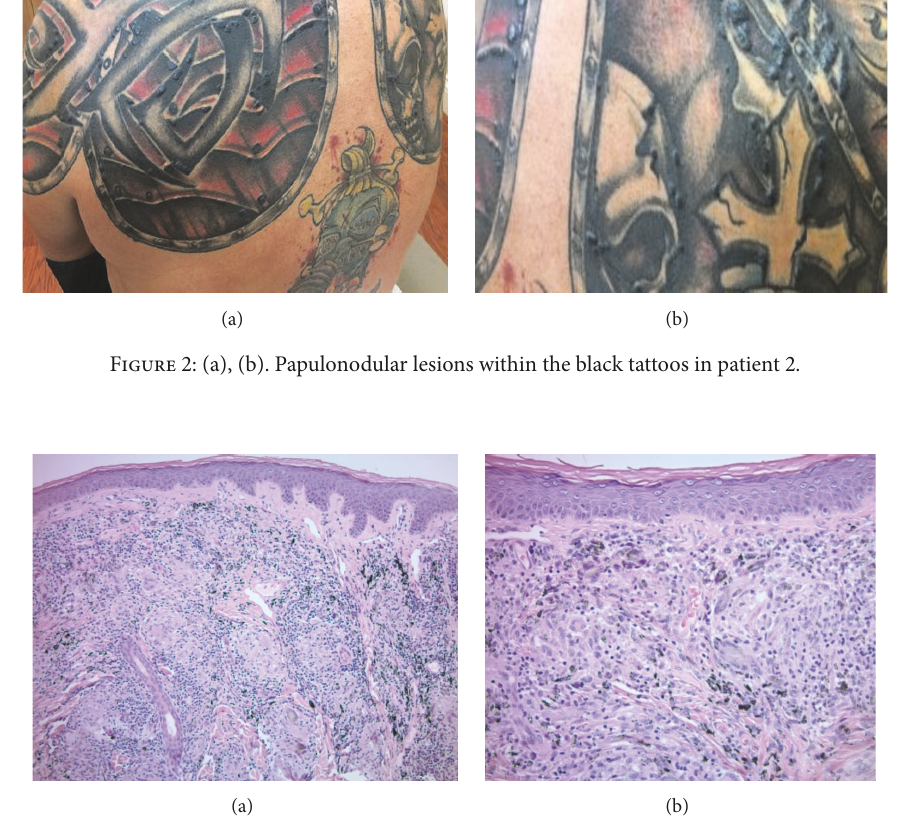
Figure 3: (a), (b). Sarcoidal-type granulomatous inflammation confined to the areas harboring black tattoo pigment (hematoxylin-eosin stain, magnifications 10 X, 20X,